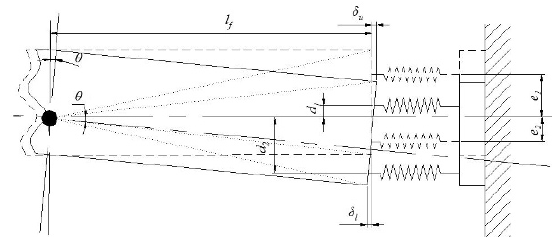
road vertical forces. Vehicle body pitching is due to vehicle braking, the different values between the upper and lower crash forces, and the different distances between upper and lower members from the vehicle’s centre of gravity.